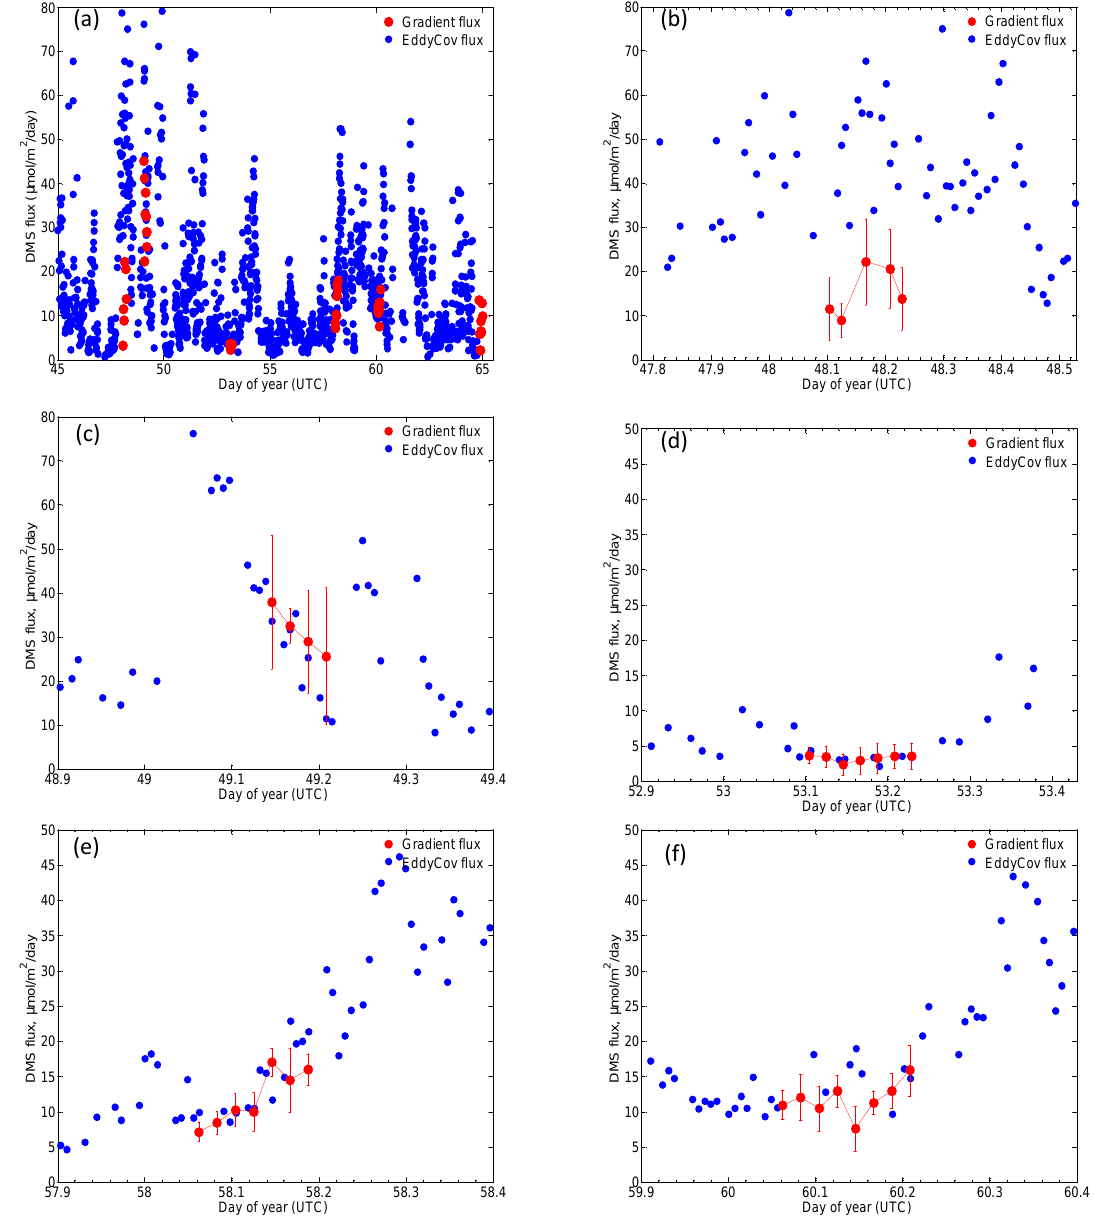
Figure 5. DMS fluxes during SOAP, estimated by eddy covariance (EC, blue dots), and gradient flux (GF, red dots) during catamaran deployments for (a) all voyage data and (b–f) individual periods of catamaran deployment, using EC u ∗ . Note the change in scale for (d–f) .